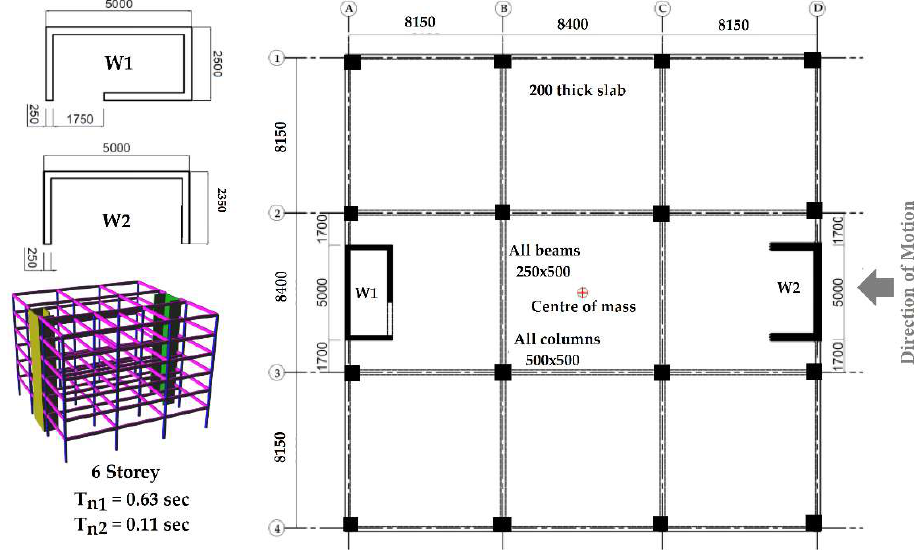
CivilEng 2023 , 4 , FOR PEER REVIEW Figure 5. Structural layout (showing positions of the frame, and walls W1 and W2), structural detailing, and elevation of case study building CSB 1 (all dimensions are in mm).